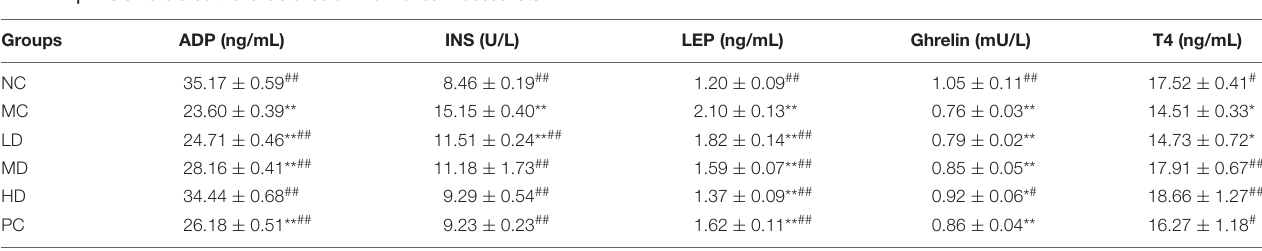
TABLE 2 | BRS ameliorated the levels of serum hormones in obese rats.